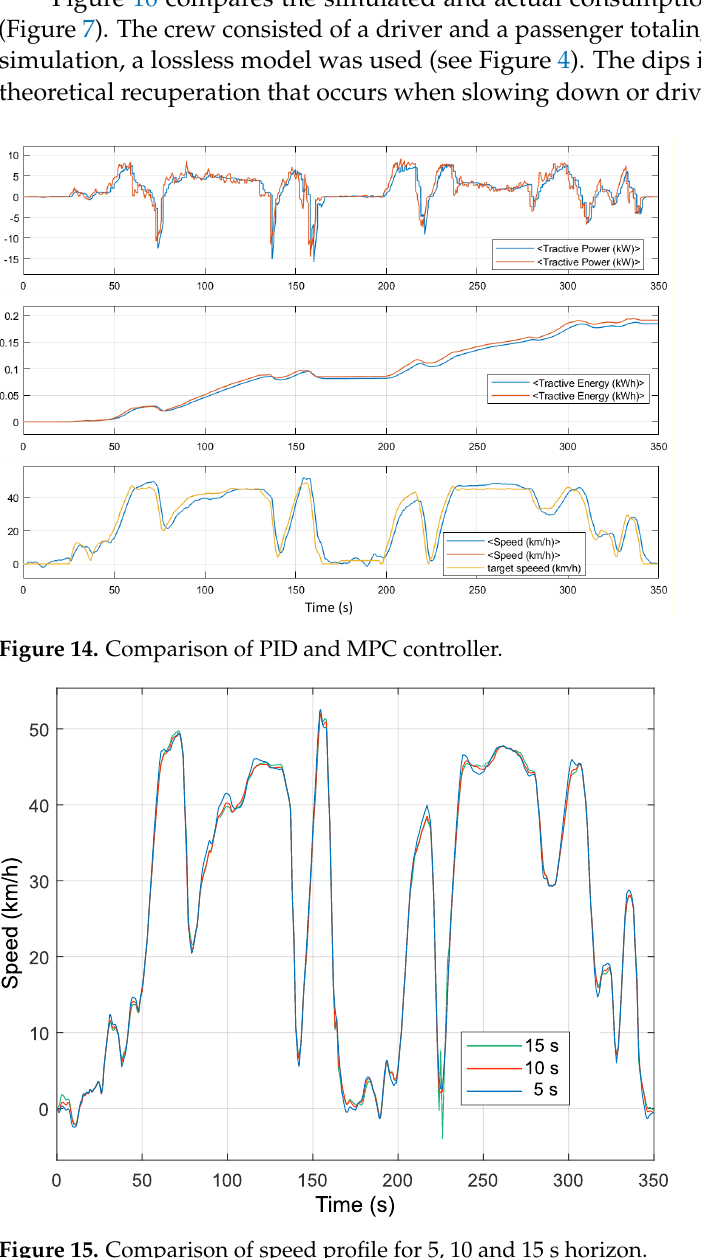
Figure 15. Comparison of speed profile for 5, 10 and 15 s